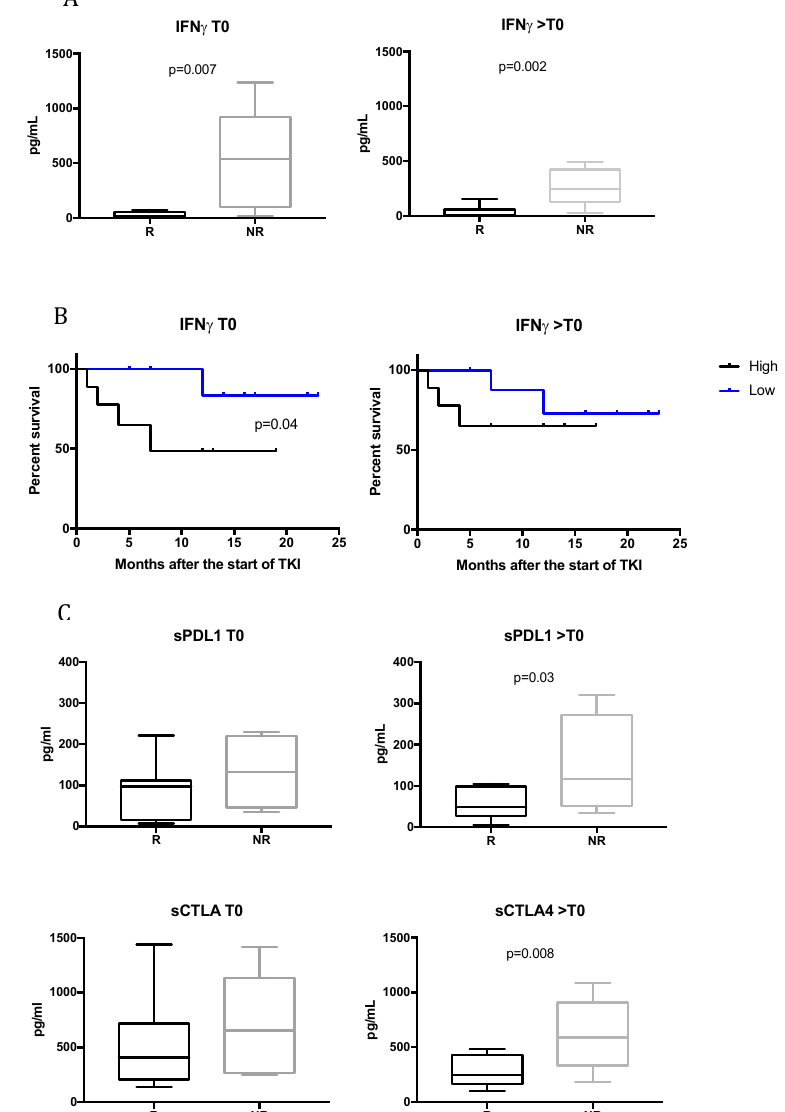
Figure 3. Profiling of levels of immune molecules at baseline and during TKI treatment in responsive (R) and non-responsive (NR) patients. ( A ) Box plots of IFN γ levels in R and NR mRCC patients at T0 and > T0. The lines in the boxes show the median values. The error bars show the minimum and maximum values. ( B ) Survival curve analysis of the mRCC patients at baseline and during TKI treatment according to the levels of IFN γ . For T0, the median value considered for patients belonging to the high-concentration group was > 65 pg / mL, while for those belonging to the low-concentration group was ≤ 65 pg / mL. For the analysis of survival during TKI treatment, the median value of IFN γ levels used to dichotomize patients was > 59 pg / mL for the high-concentration group and ≤ 59 pg / mL for the low-concentration group. A log-rank test was used to compare the survival between two groups. ( C ) Box plots of sPDL1 and sCTLA4 at baseline and 3–4 months after the start of TKI therapy ( > T0). A Student’s unpaired t -test was used to compare R vs. NR patients and a p -value < 0.05 was considered statistically significant.